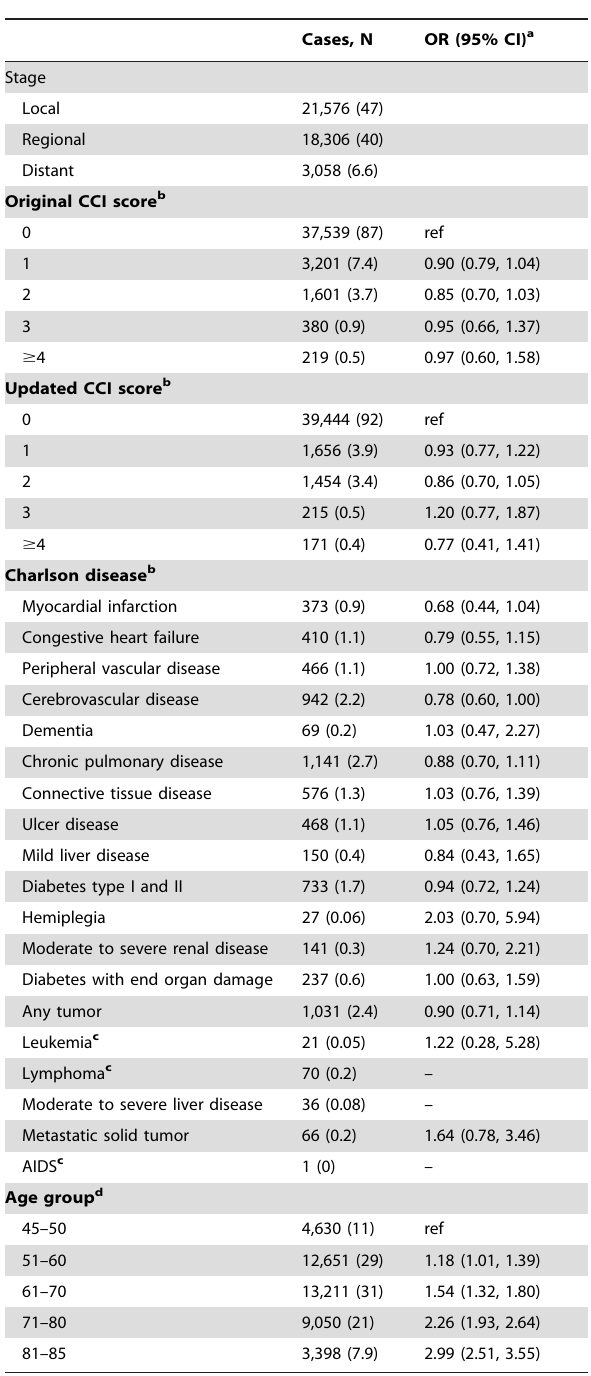
a Calculated as distant stage vs. local/regional stage breast cancer at diagnosis. Patients with unknown stage (n=3,384) were excluded from the analysis. b Adjusted for age as a continuous variable. c Zero cases of distant stage breast cancer. d Adjusted for original CCI score in five categories. Abbreviations. OR: odds